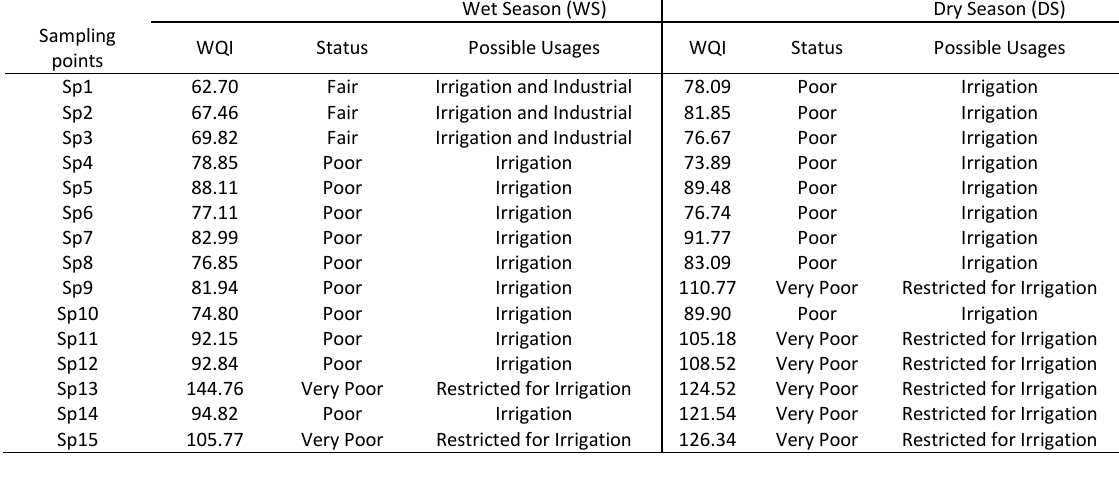
Table 6: WQI for all the 15 sampling stations